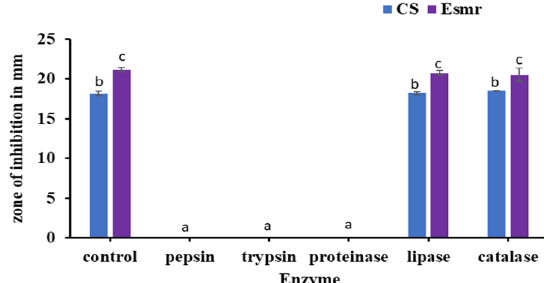
Fig. 1 Effect of various enzymes on the antimicrobial activity of CS and purified ESmr18. CS and ESmr18 were treated with 1 mg/ ml of various enzymes for 1 h and the residual antimicrobial activity was tested by agar well diffusion assay after heat-inactivation of the enzymes. The untreated CS and ESmr18 were used as control. Error bars are representative of mean SD of the three independent ± experiments performed in triplicates. Letters a, b and c denote significant differences at p < 0.05